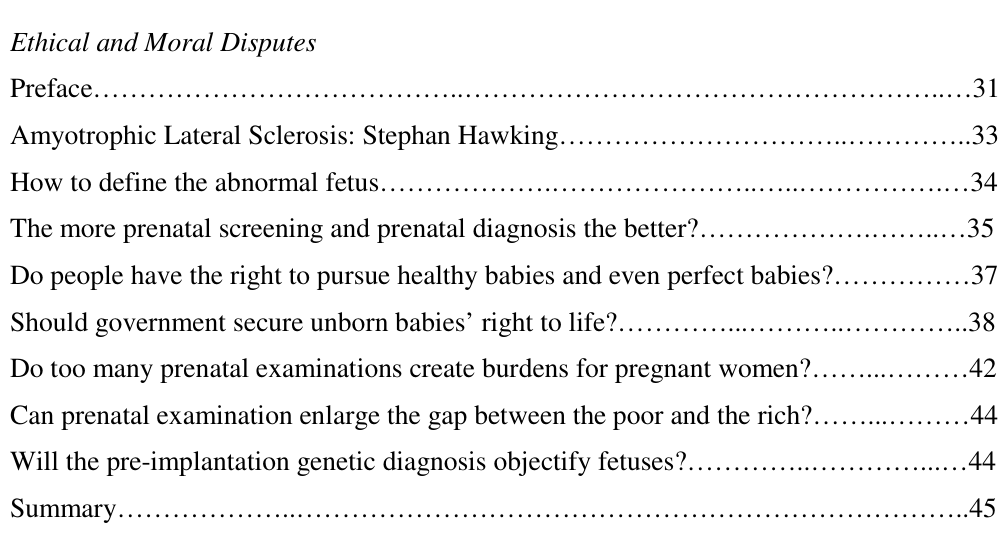
National Regulations and Government Subsidies Informed